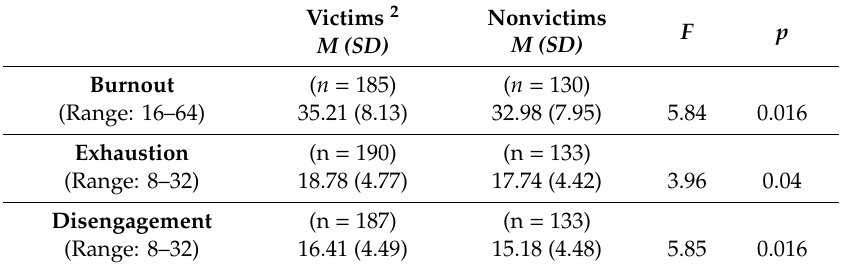
Table 2. Burnout (exhaustion and disengagement): comparison between victims and nonvictims (one-way